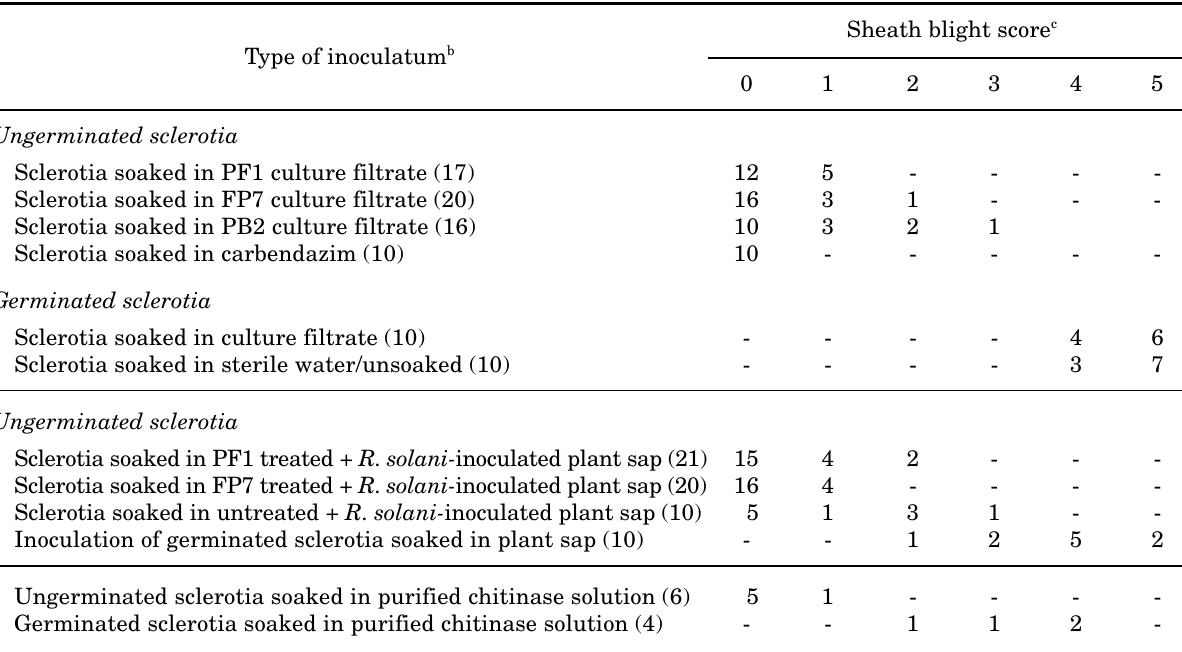
Table 4. Viability of ungerminated and germinated a sclerotia upon inoculation in rice plants. Individual experi- ments are separated by horizontal